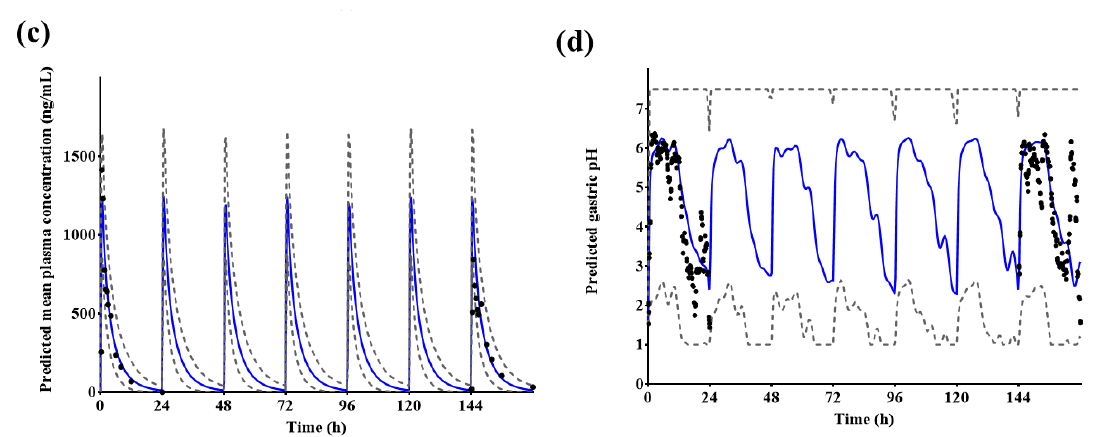
Figure 6. Predicted ( a , c ) plasma tegoprazan concentration and ( b , d ) gastric acid pH – time profiles after repeated administrations of 100 mg tegoprazan once daily for 7 days. Blue solid lines represent the predicted mean values, gray dotted lines represent the predicted 5th and 95th percentile, and black dots represent the observed plasma tegoprazan concentration or gastric acid pH profiles, respectively.